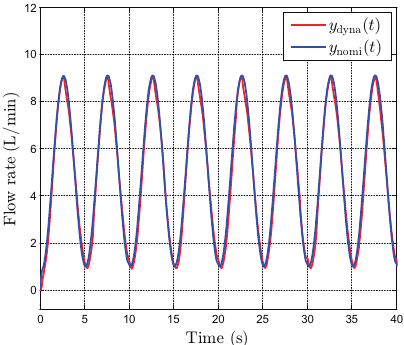
Figure 10. Experimental validation of the nominal